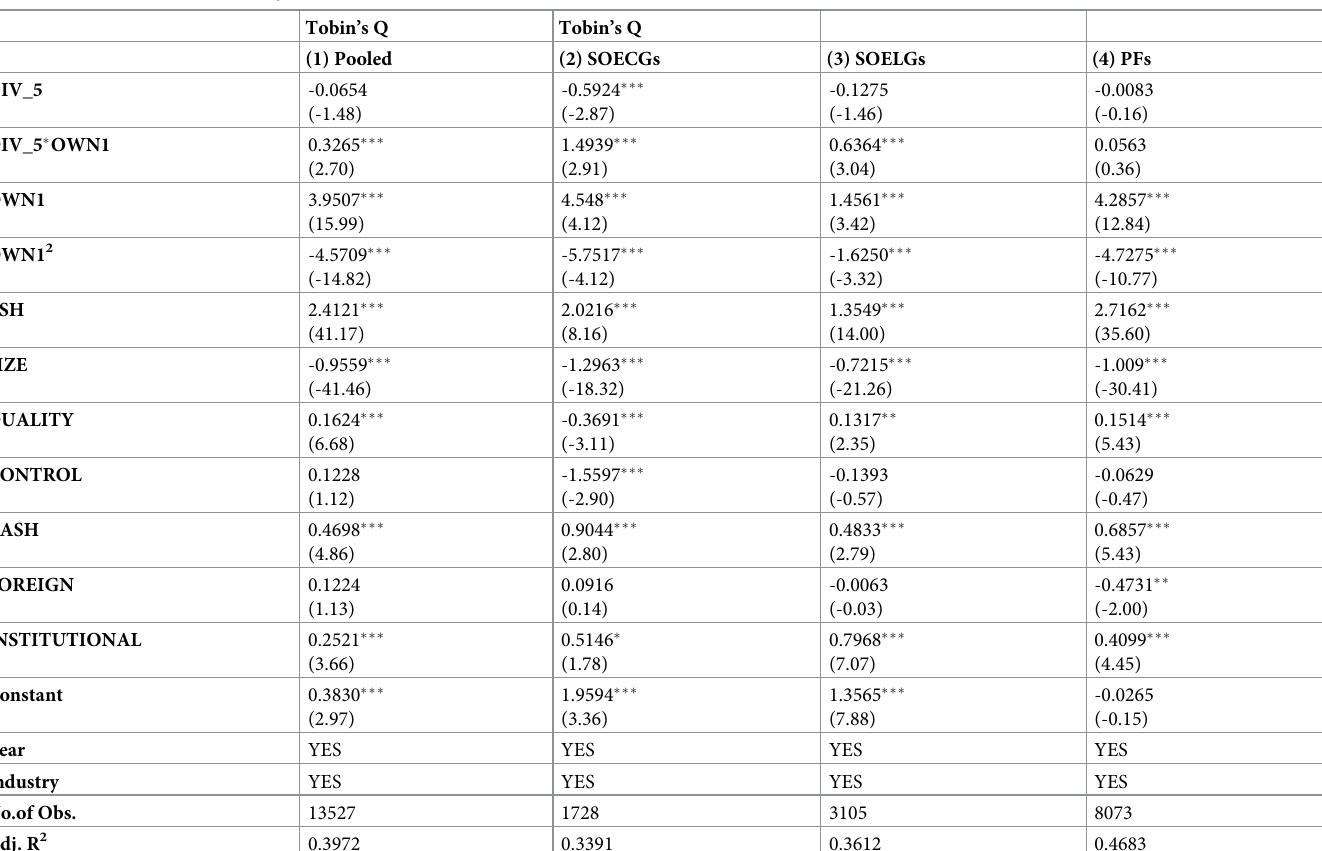
Table 7. Robustness test: Tobin’s Q as an alternative measure of firm